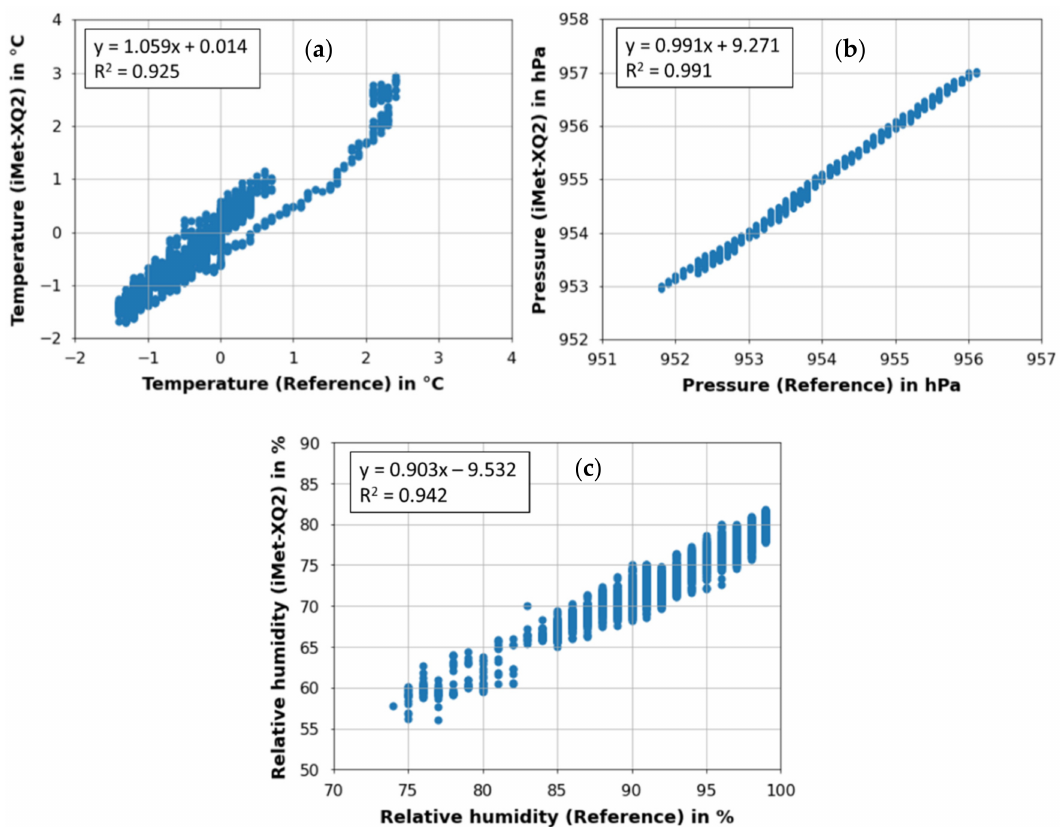
Figure 19. Comparison of ( a ) air temperature, ( b ) air pressure, and ( c ) relative humidity results (iMet-XQ2) with the reference device